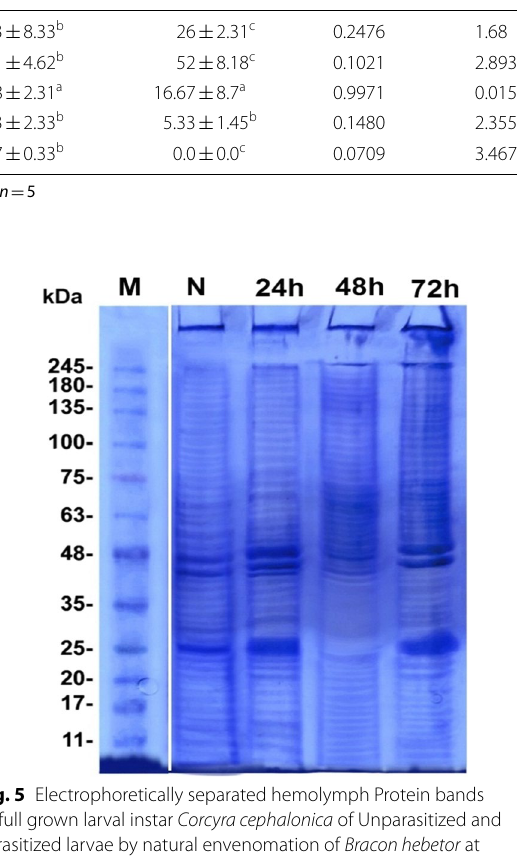
Table 1 Differential Hemocytes Count (DHC) in the hemolymph of fully developed larvae of C. cephalonica before and after successive periods of parasitization by B. hebetor